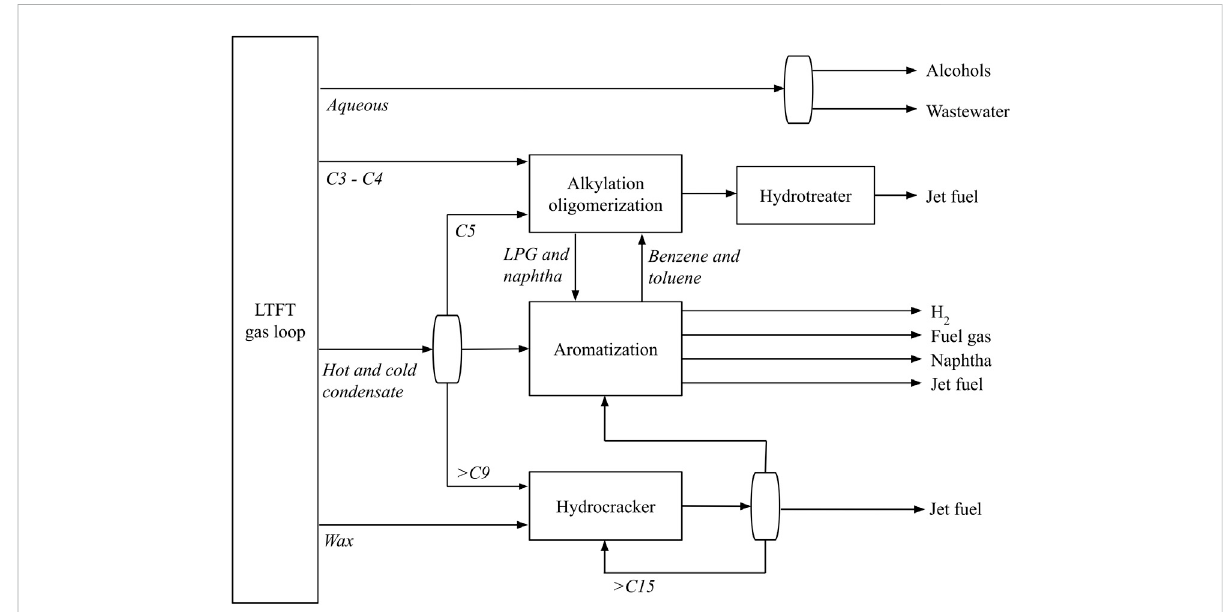
FIGURE 2 The re fi nement process for the production of jet fuel from a LTFT plant. Adapated from de Klerk